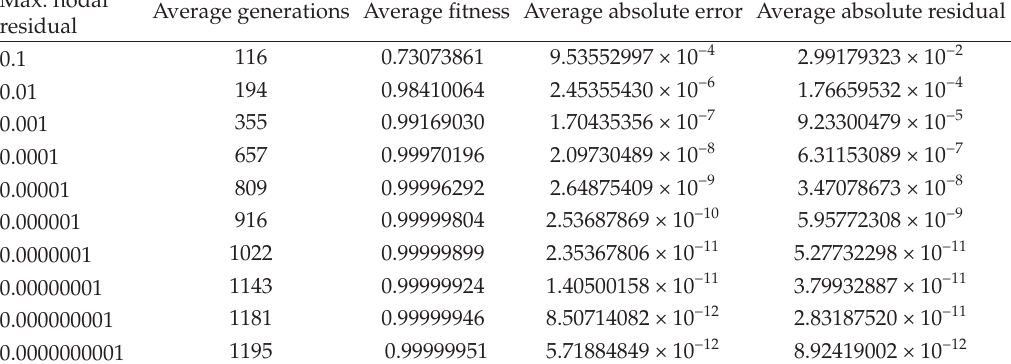
Table 14: The influence of the maximum nodal residual on the convergence speed and the corresponding error for Problem 3.